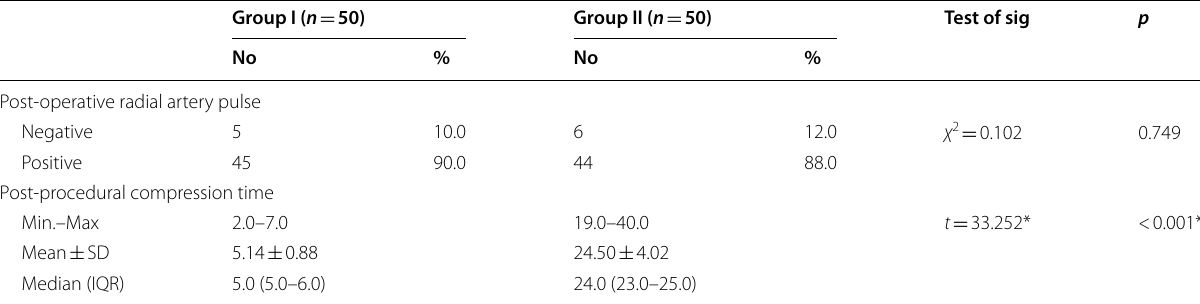
Table 8 Comparison between the two studied groups according to post-operative radial artery pulse and post-procedural compression